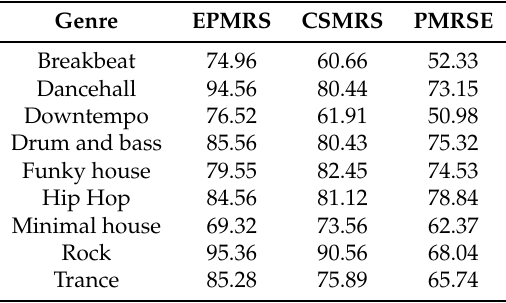
Table 1. The accuracy (%) of song recommendations in the nine genres for the 100